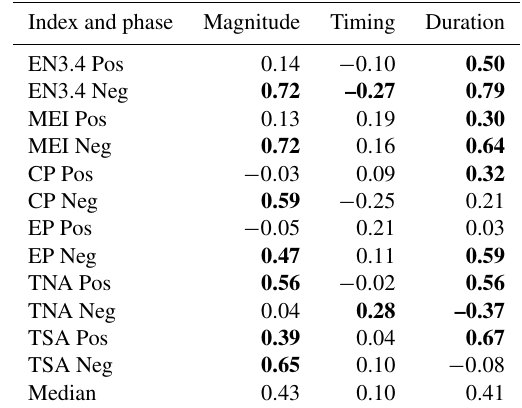
Table 1. Pearson’s correlation coefficients between observed and GloFAS 2.1 results of the differences between climate phases for all indices (e.g. EN3.4 positive minus EN3.4 neutral) for flood magni- tude, timing and duration. Values in bold are significant at the 95% confidence